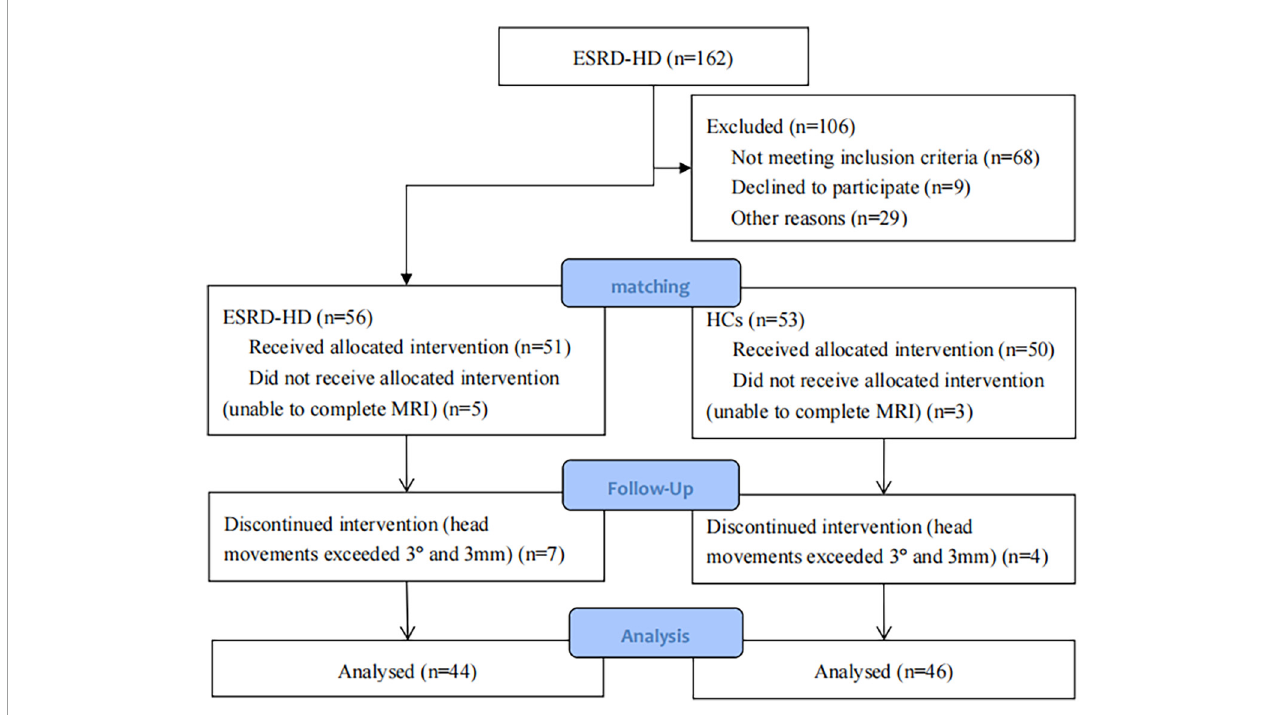
FIGURE1 Flow diagram of sample selection. ESRD-HD, end-stage renal disease patients undergoing hemodialysis; HCs, healthy controls.